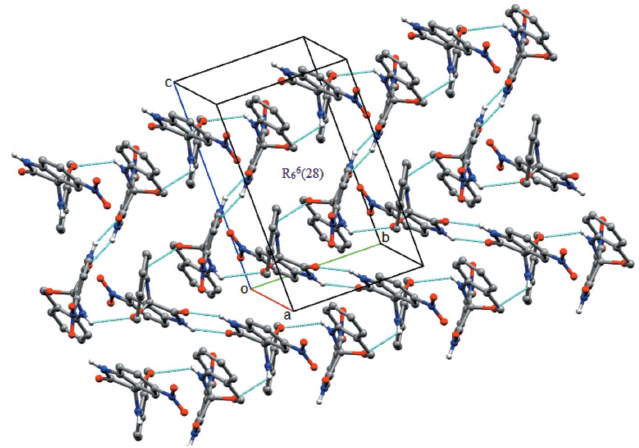
Figure 5 A part of crystal structure showing the formation of a sheet along [010], generating an R 6 (28) loop for each set of six molecules. 6